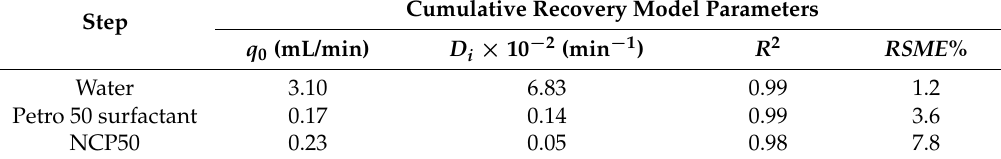
Table 2. Cumulative recovery model parameters for oil recovery in a quarter five-spot pattern micromodel for the injection of water, and aqueous solutions of dissolved 10 mg/L of Petro 50 surfactant, or 10 mg/L of NCP50 material.